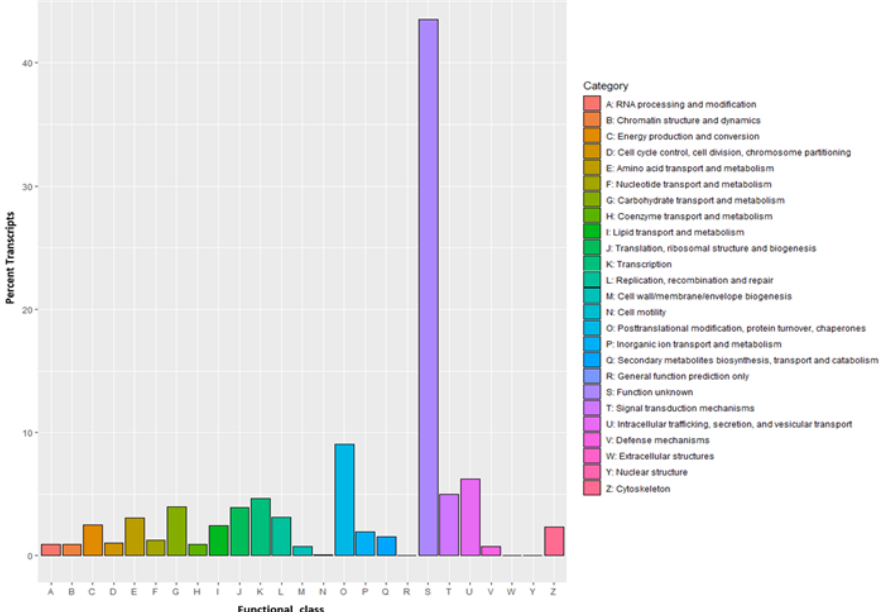
Figure 5. The Cluster of Orthologous Groups (COG) classification of the de novo assembled tran- scripts. Percentage transcripts are represented on the y-axis for each COG functional class on the x-axis.